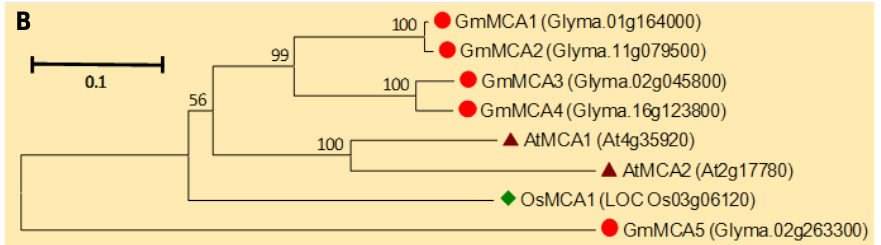
Figure 10. Schematic representation of functional domains of soybean Mid1-complementing activity (MCA) family proteins ( A ). Unrooted phylogenetic tree of the MCA family proteins from soybean ( Glycine max ), rice ( Oryza sativa ), and Arabidopsis thaliana ( B ). Soybean MCAs are marked with red circles, Arabidopsis MCAs were marked with purple triangles, while rice MCA1 were marked with green diamonds. The bar indicates the relative divergence of the sequences examined, and bootstrap values are displayed next to the branch.